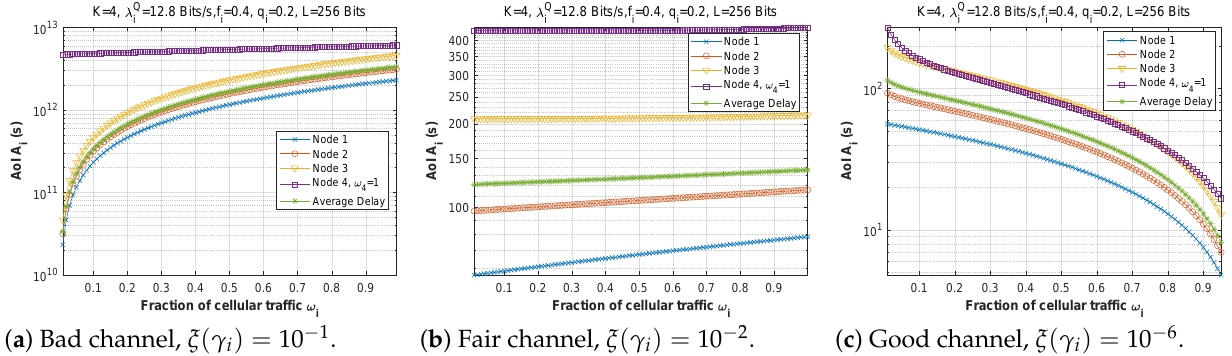
Figure 30. Setting 1: The AoI experienced at each mobile device when varying the fraction of cellular traffic with the bit error rate ξ ( γ i ) .